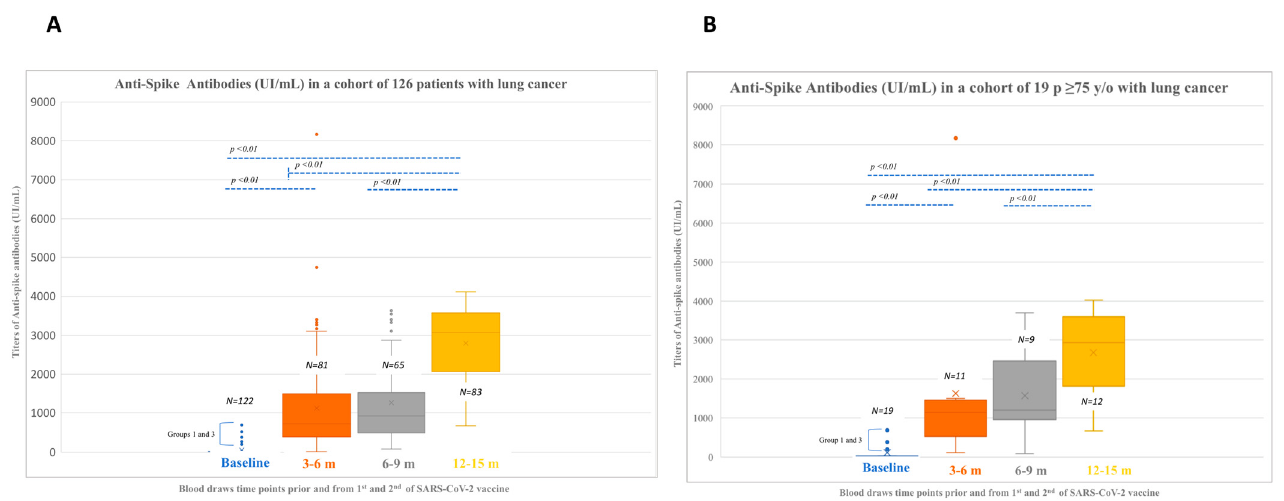
Figure 2. ( A ). Anti-spike antibodies titers in a cohort of 126 patients with lung cancer. ( B ). Anti-spike antibodies in the subgroup of 19 patients with lung cancer aged >75. (baseline samples were evalu- able from 122 and 19 patients from groups A and B, respectively). Legend: m,